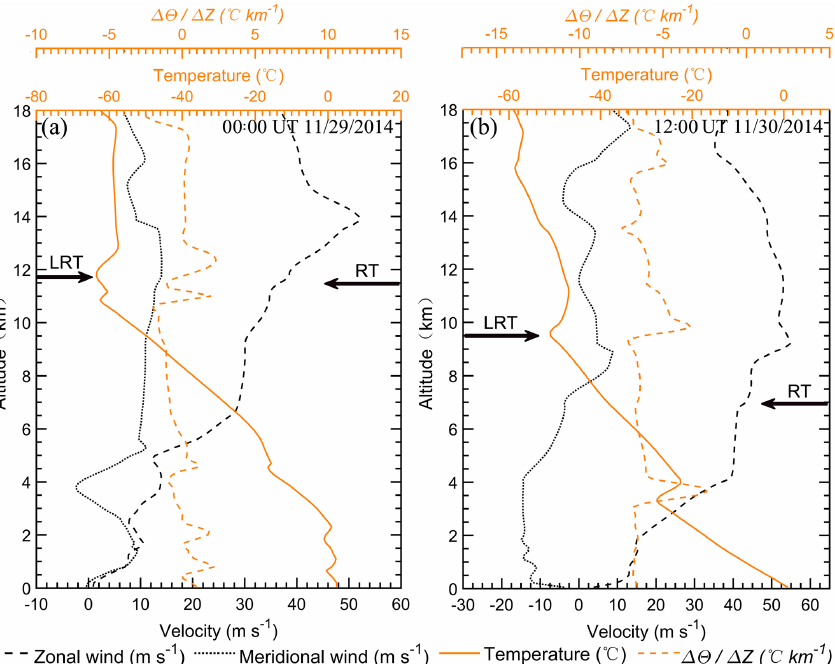
Figure 6. Vertical profiles of zonal wind, meridional wind, temperature, and potential temperature gradient derived from the GPS radiosonde measurements, at (a) 00:00UTC 29 and (b) 12:00UTC 30 November 2014. The bold arrows on the left and right site of each panel indicate the radiosonde-derived LRT tropopause and radar-derived tropopause height,